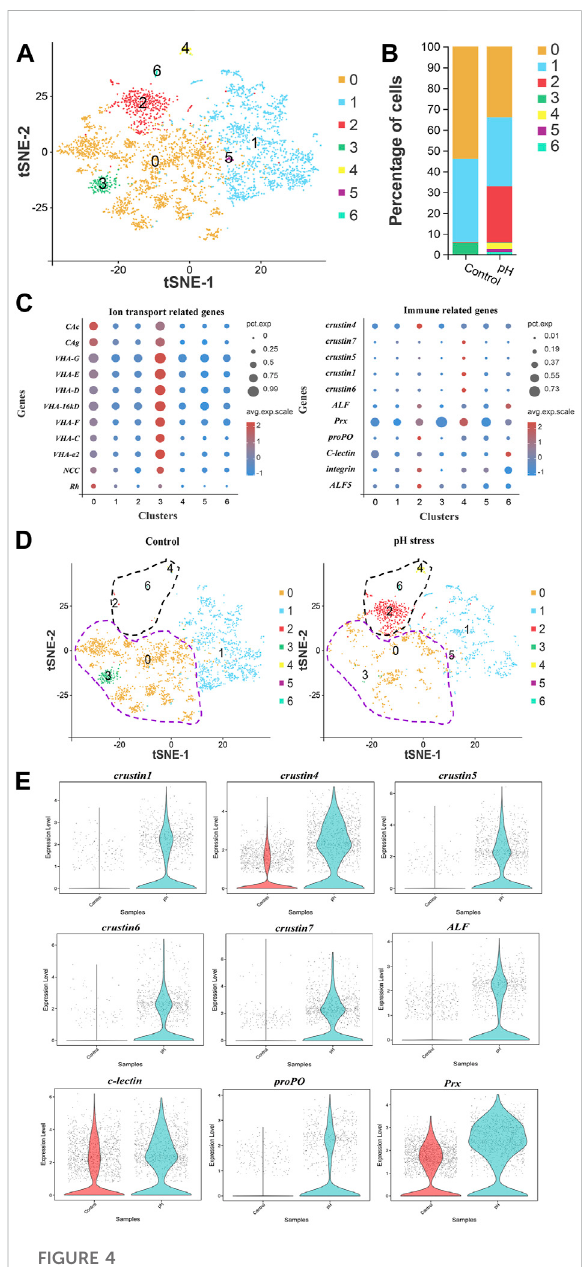
FIGURE 4 Heterogeneity of pillar cells between control and pH groups. (A) The t-SNE plot showing the seven subclusters identi fi ed in the pillar cells. (B) The percentage of each subcluster in control and pH group. (C) Dot plot representing ion transport genes and immune related genes in each subcluster of pillar cells. (D) The t-SNE plot showing the renames of subclusters in the pillar cells. The purple dotted circle indicated the ion cells, and the black dotted circle indicated the immune cells. (E) Violin diagram showing expression level of some immune related genes in the immune cells of pillar cells in the control and pH